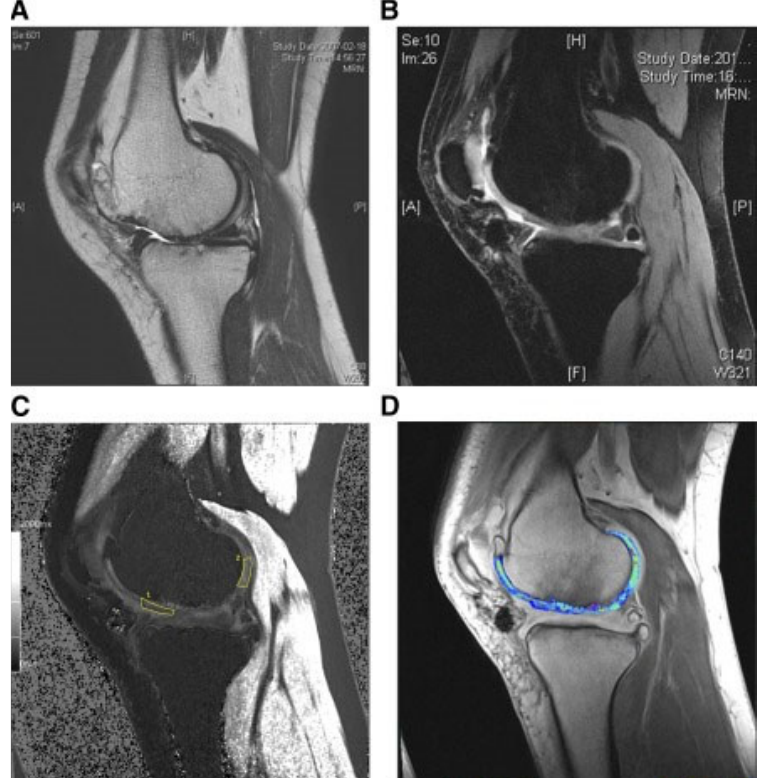
Figure 3. MRI evaluation of cartilage regeneration 3 years after HUCB ‐ MSC treatment. ( A ) A preoperative cartilage defect. ( B ) Cartilage regeneration at 3 years post ‐ transplantation. ( C ) The change in relative cartilage relaxation rate was calculated by sampling in the marked area. ( D ) An increased GAG content is shown in relation to the blue signal. Reprinted from [118]. MRI, magnetic resonance imaging; HUCB ‐ MSCs, human umbilical cord blood ‐ derived mesenchymal stem cells; GAG: glycosaminoglycan.